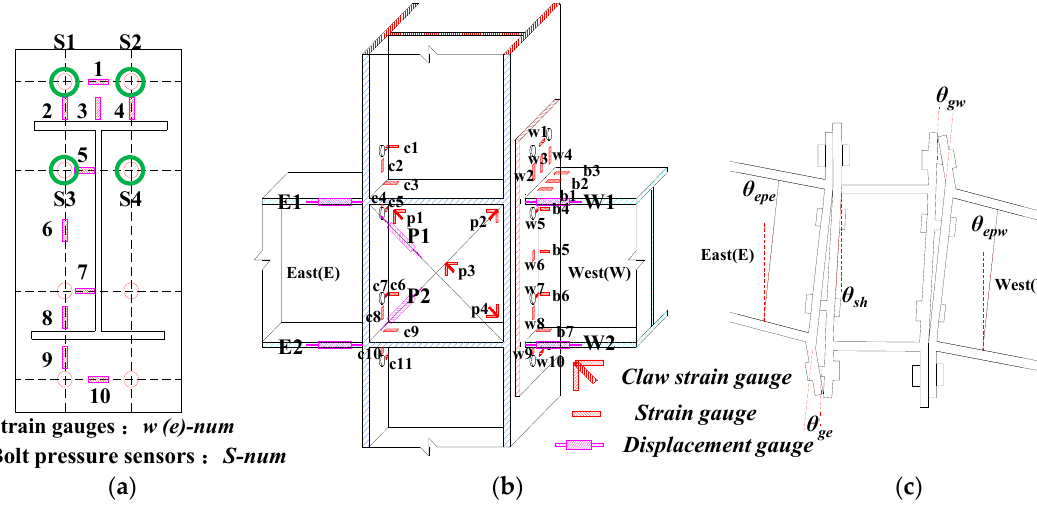
Figure 6. Schematic diagram of measuring point’s layout and rotation angle ( θ ) definition: ( a ) End-plate strain gauge arrangement; ( b ) Strain gauge test setup; ( c ) Schematic of the relative rotation angle of the beam column.